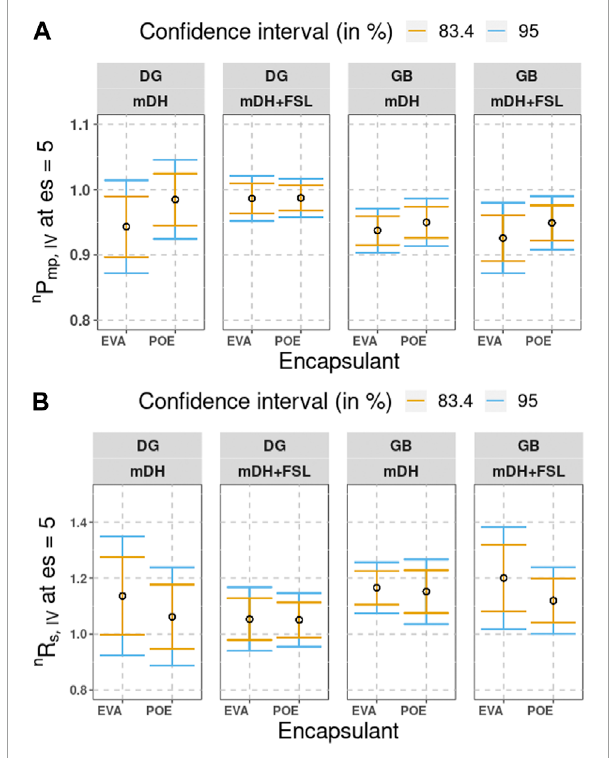
FIGURE 3 Confidence intervals of 83.4% (orange) and 95% (blue) at the end of exposure for minimodules fabricated by manufacturer B. The hollow black circles represent the estimated means. Each CI for each minimodule variant makes use of 8 cell-level measurements to improve the statistical signficance of the results. (A) n P mp , IV . (B) n R s , IV .